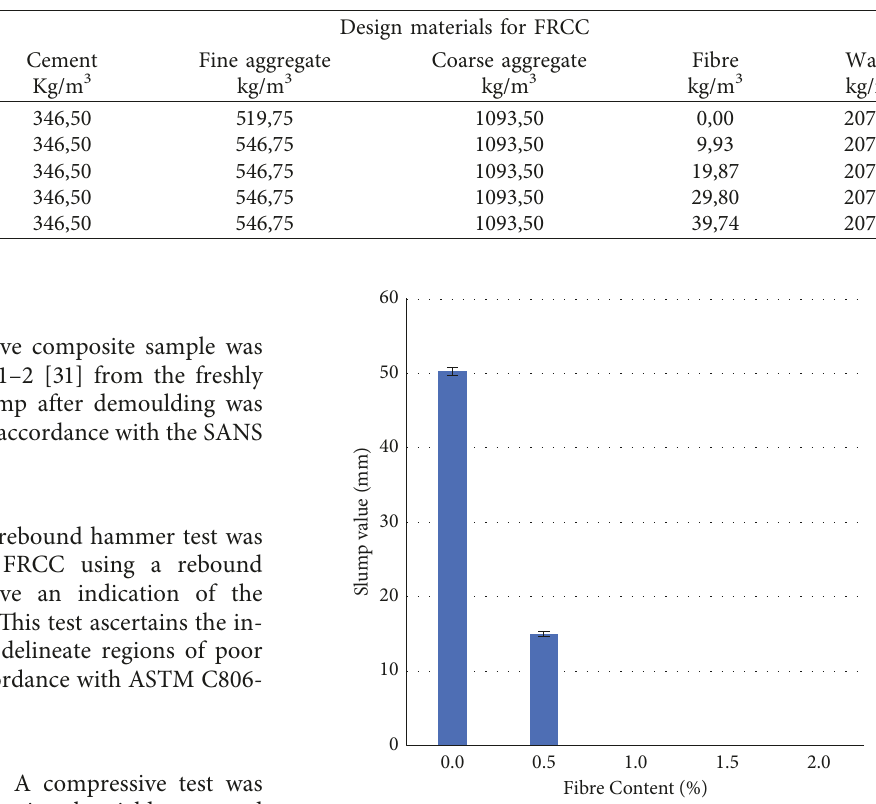
Table 5: Fibre reinforced concrete design mix.